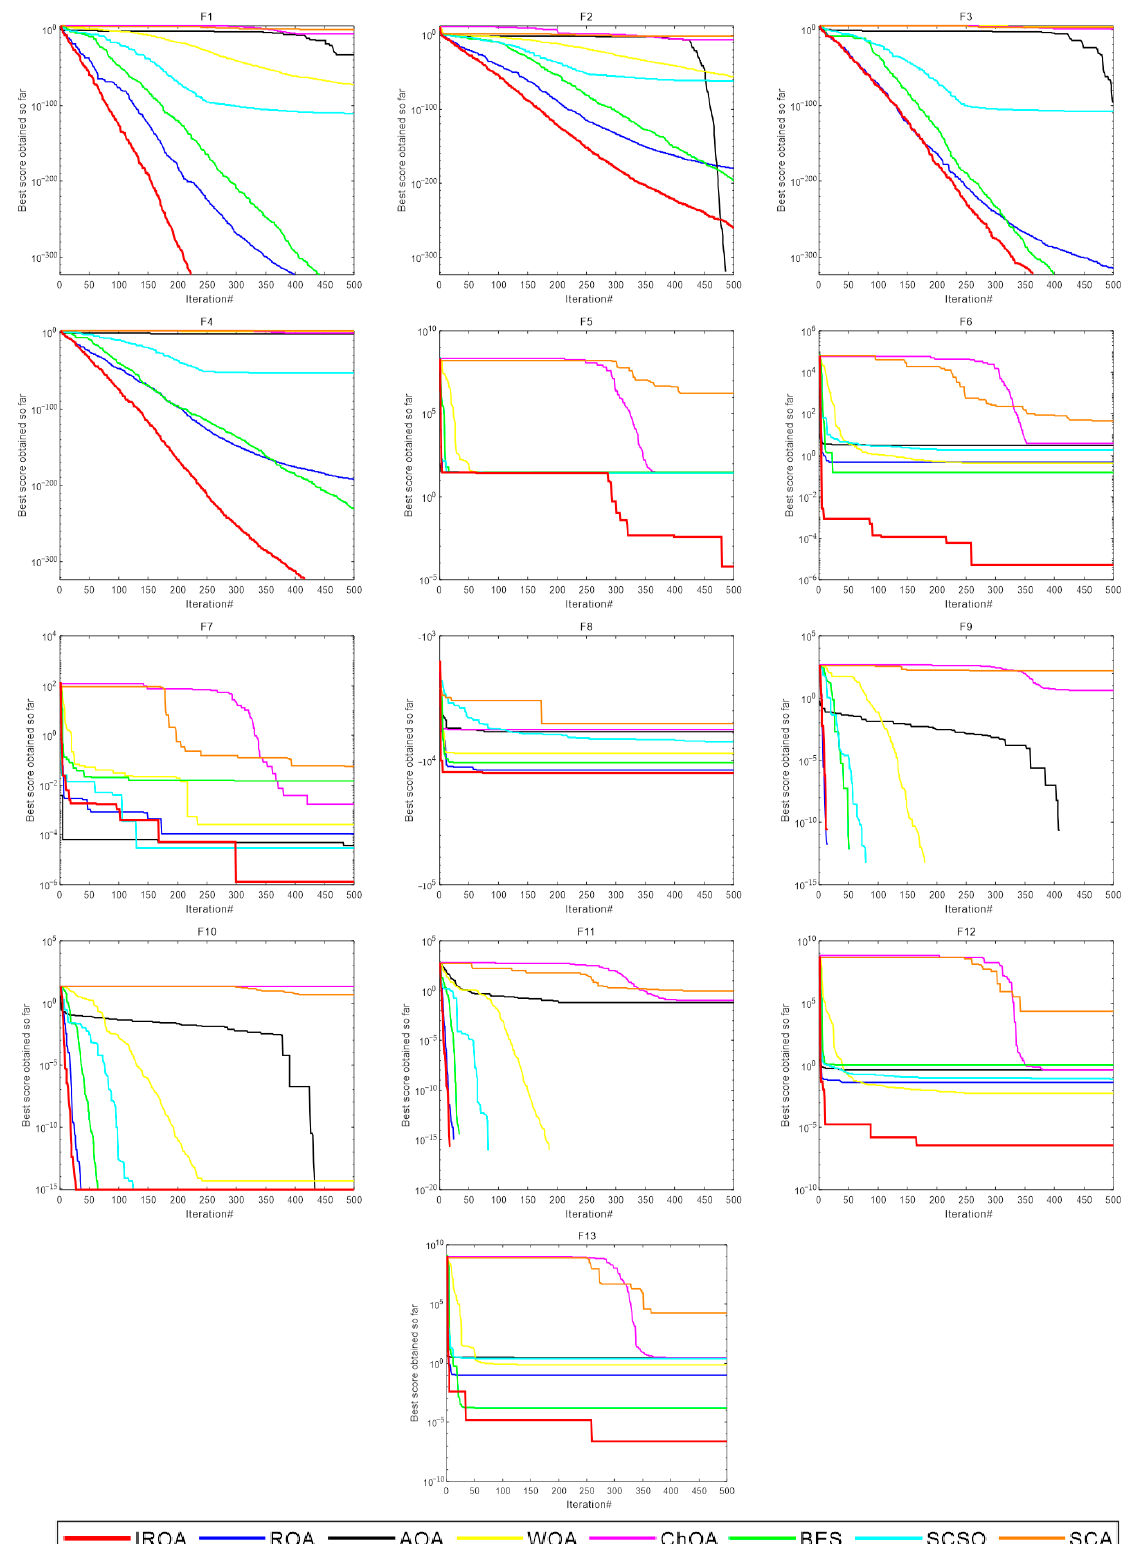
Figure 4. Convergence curves of each algorithm for standard benchmark functions ( F1 – F13 ) at dim = 30.